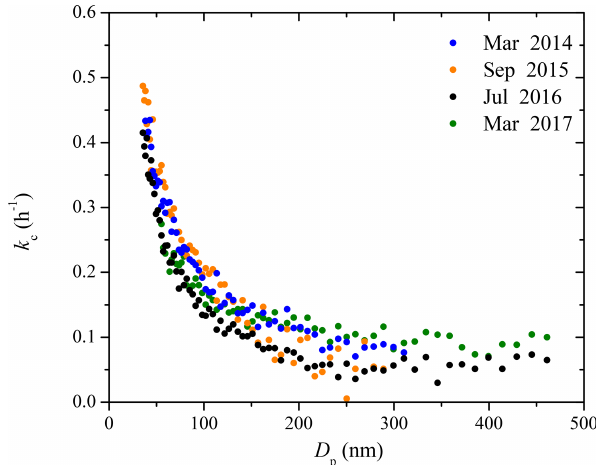
Figure 3. The k c (D p ) profiles for the 12m 3 CMU Teflon chamber over a span of 3 years. The particle wall-loss rate constants were derived based on SMPS measurements from experiments with only ammonium sulfate